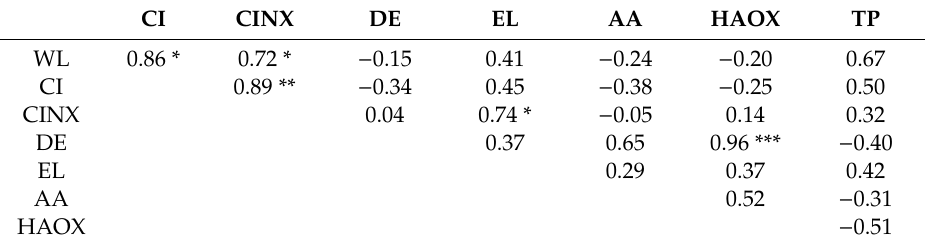
Table 4. Correlation coe ffi cients for the relationships between weight loss (WL), chilling injury (CI), chilling index (CINX), decay (DE), elasticity (EL), ascorbic acid content (AA), hydrophilic antioxidant (HAOX) content and total phenolic (TP) content in yellow pepper, cv. Dinamo, after 21 days of storage at 1.5 ◦ C, followed by 3 days of storage at 21 ◦ C, in combination with Xtend ®